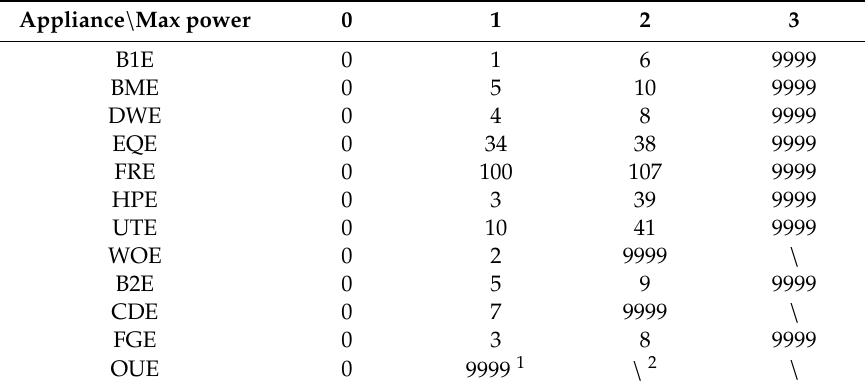
Table 3. Stephen’s state quantization results.